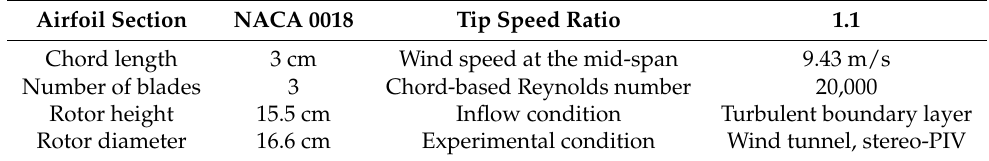
Table 2. The basic information of the experiment.